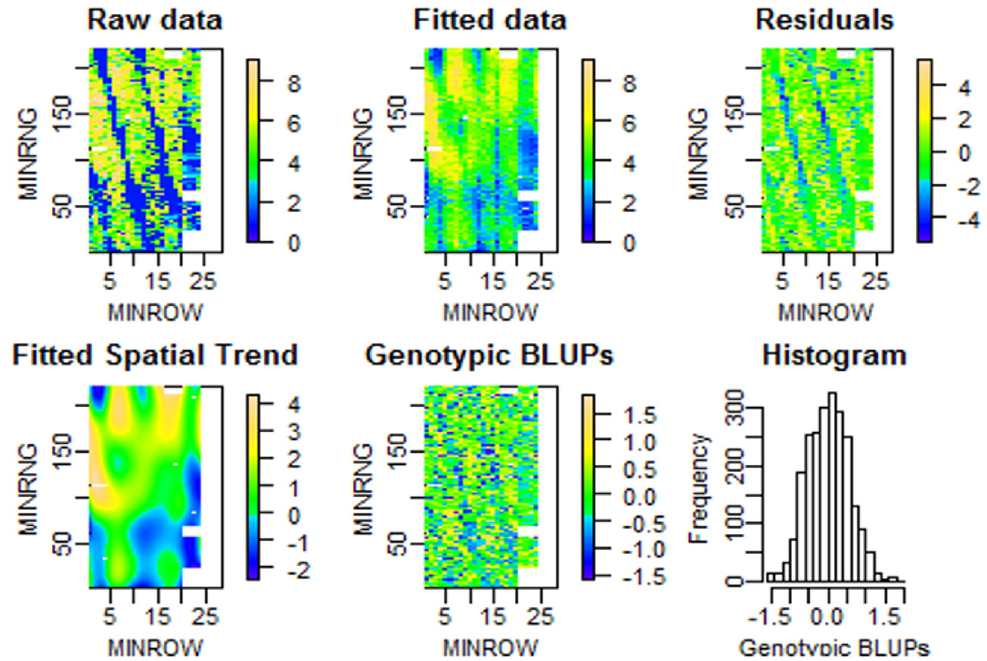
Figure 5. Heatmaps and histogram from data set 2. The rectangle layout is 26 rows (X-axis) by 220 ranges (Y-axis) with a total of 5720 plots. The white area on the right side of each heatmap is the plot with missing data. Sub-figures show values either from the raw field image, or as indicated in headings: fitted, or corrected with residuals or genomic BLUP values.